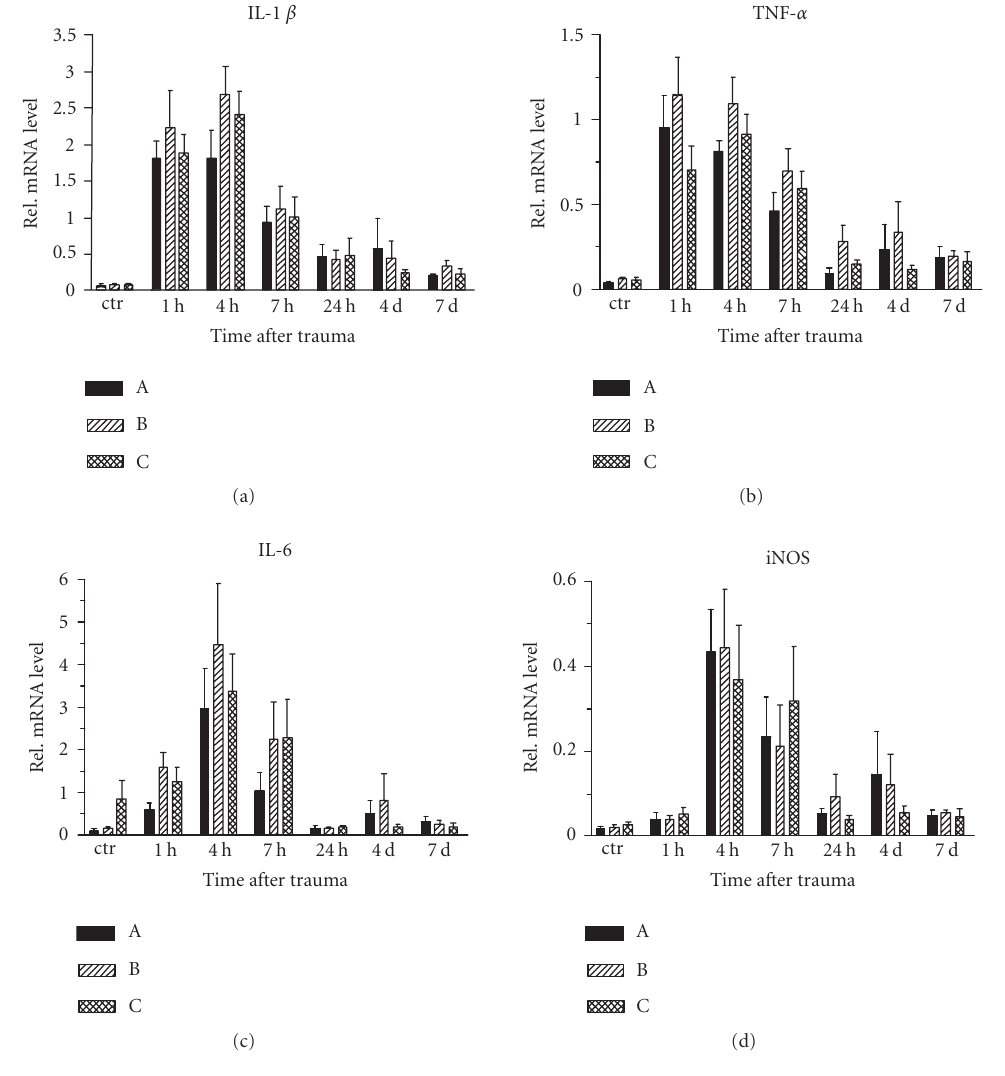
Figure 1: Time course of mRNA for IL-1 β , TNF- α , IL-6, and iNOS in tissue sampled at the impact place (A) and the left (B) and right (C) piriform cortices. Values are expressed as mean ± SD ( n =